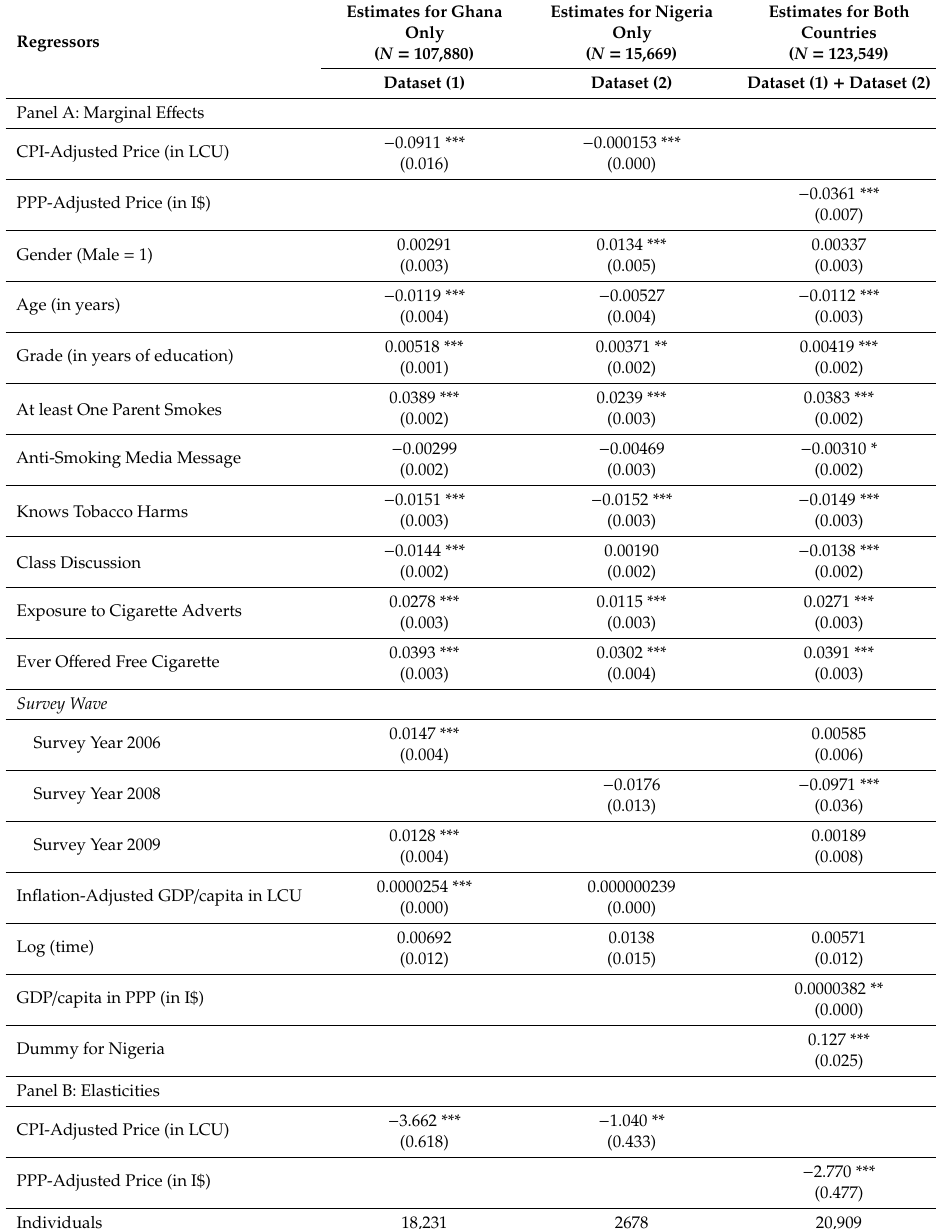
Table 4. Complementary log-log (cloglog) survival models of tobacco use initiation among youth (ages 8–18) in Ghana and Nigeria (standard errors in